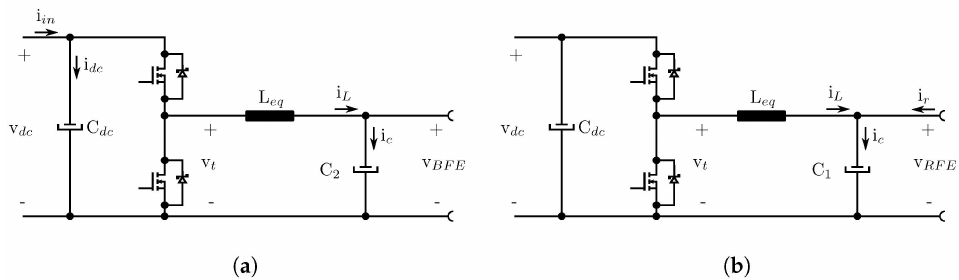
Figure 8. ( a ) Equivalent converter circuit diagram: ( a ) BFE and ( b ) RFE .